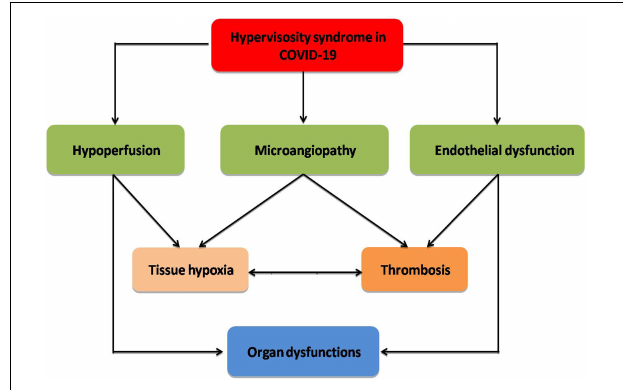
FIGURE 2 | Complications of hyperviscosity syndrome in COVID-19: Hyperviscosity syndrome provokes the development of endothelial dysfunction, microangiopathy, and hypoperfusion with the development of thrombosis and tissue hypoxia, which eventually cause organ